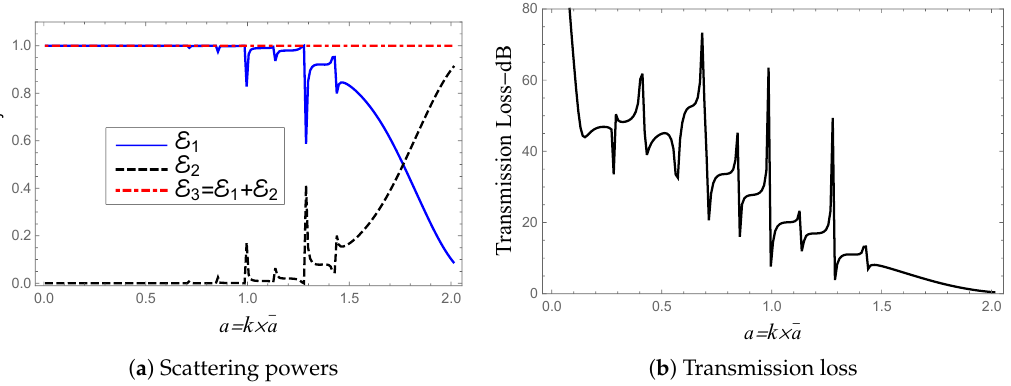
Figure 10. Chamber problem: Scattering powers and transmission loss against non-dimensional radius a with f = 550 Hz, ¯ b = 0.2 m, and ¯ L = 0.05